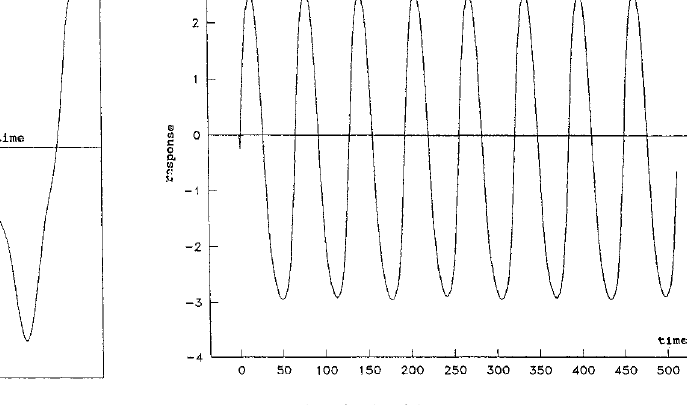
Fig. 6d. Time history q = 0 : 287361.